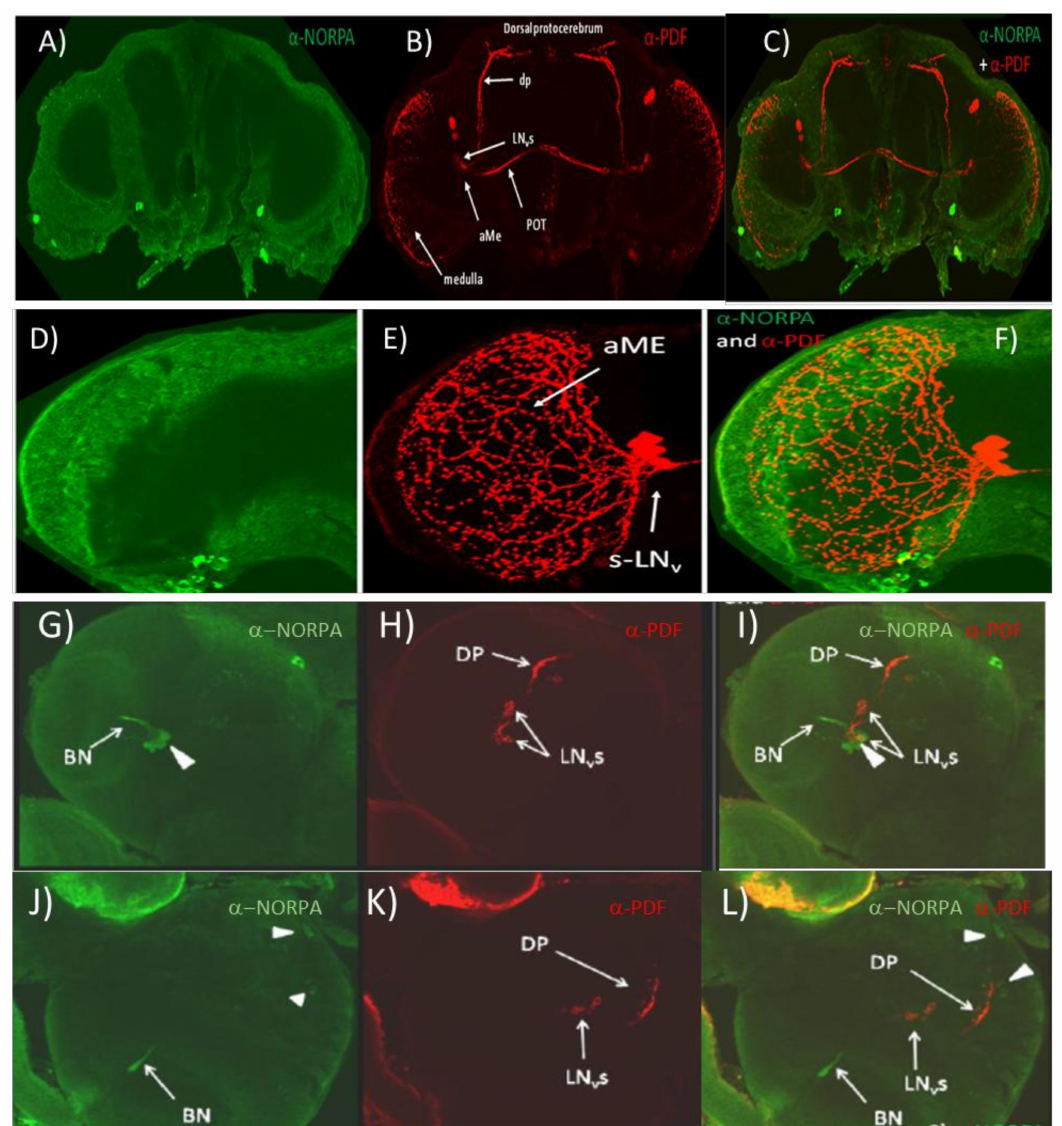
Figure 1. NORPA and PDF expression in adult and larval brains ( A – C ). Drosophila adult brain in which NORPA was overexpressed in the PDF neurons via Pdfgal4. ( A ) α -NORPA signal (green), ( B ) α -PDF signal (red), and ( C ) Merge of images ( A ) and ( B ). ( D – F ). Enlargement of an optic lobe overexpressing NORPA in PDF neurons. ( D ) α -NORPA (green), ( E ) α -PDF (red), and ( F ) Merged of ( D ) and ( E ) signals. ( G – I ). Ventral view of 3rd instar brain of w 1118 larva. ( G ) α -NORPA (green), ( H ) α -PDF (red), and ( I ) merge. BN, Bolwig neuron; DP, dorsal projection of LNvs. Arrowhead on panel I shows LNv neuron that may be co-expressing both NORPA and PDF. ( J – L ). Dorsal view of 3rd instar brain of w 1118 larva. ( J ) α -NORPA (green), ( K ) α -PDF (red), and ( L ) merge. Arrowheads in panel L show putative α -NORPA staining in